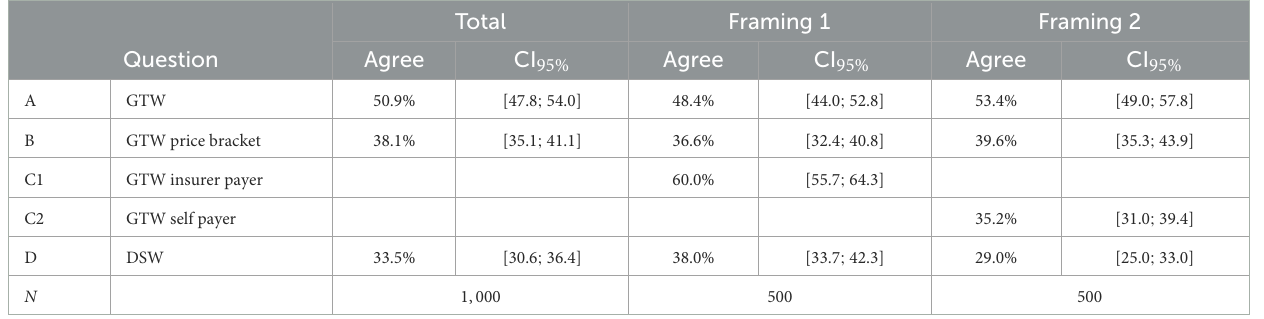
TABLE 2 Average level of agreement with 95% confidence